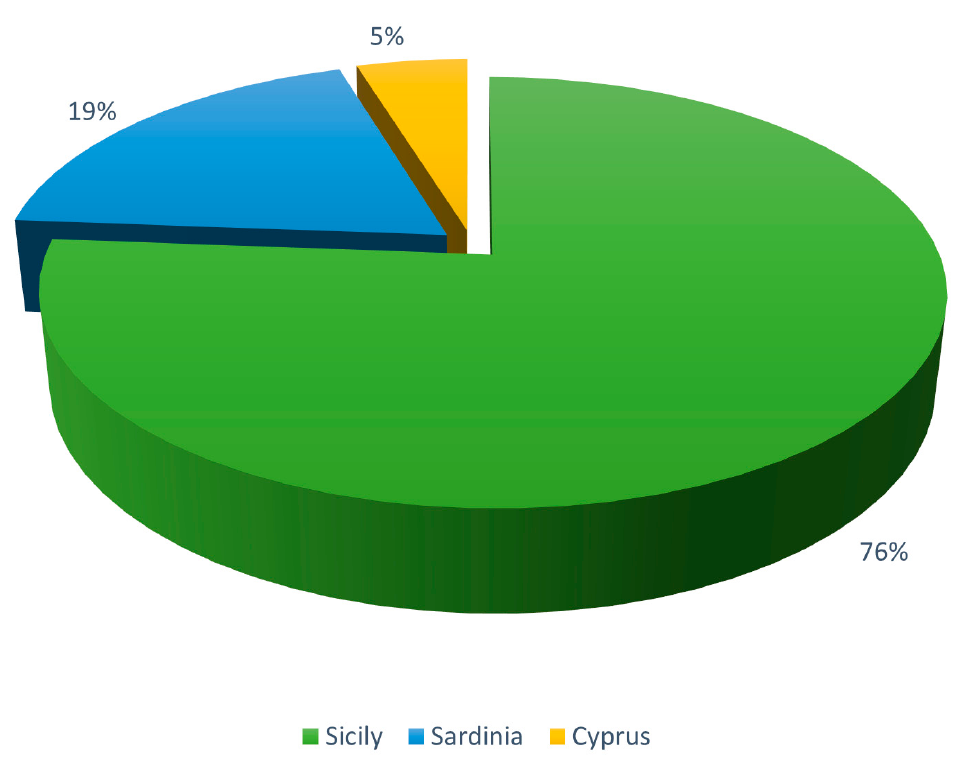
Figure 9. Percentage of “Extreme rainfall and floods” articles of Mediterranean bioregion grouped into islands.